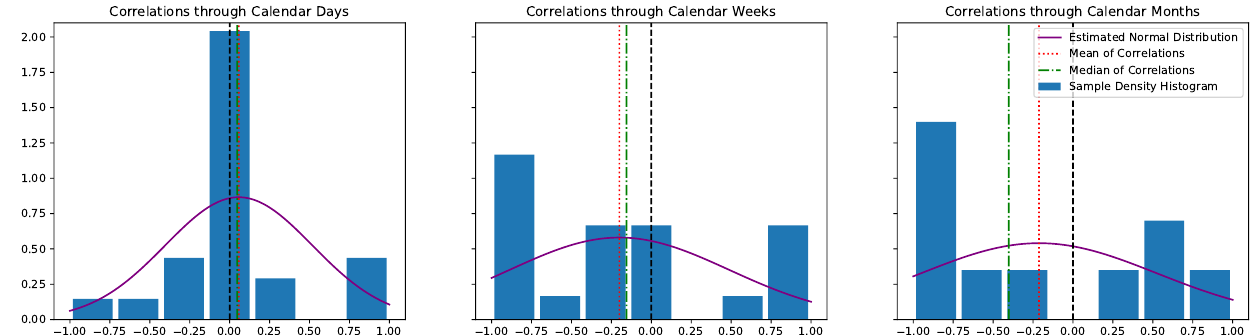
Figure 5. Histogram of correlations between fuel consumption rate (FCR) percentile and attention horizon (AH) percentile through time for individual drivers; these parameters are obtained for days (leftmost), weeks (middle), and months (rightmost